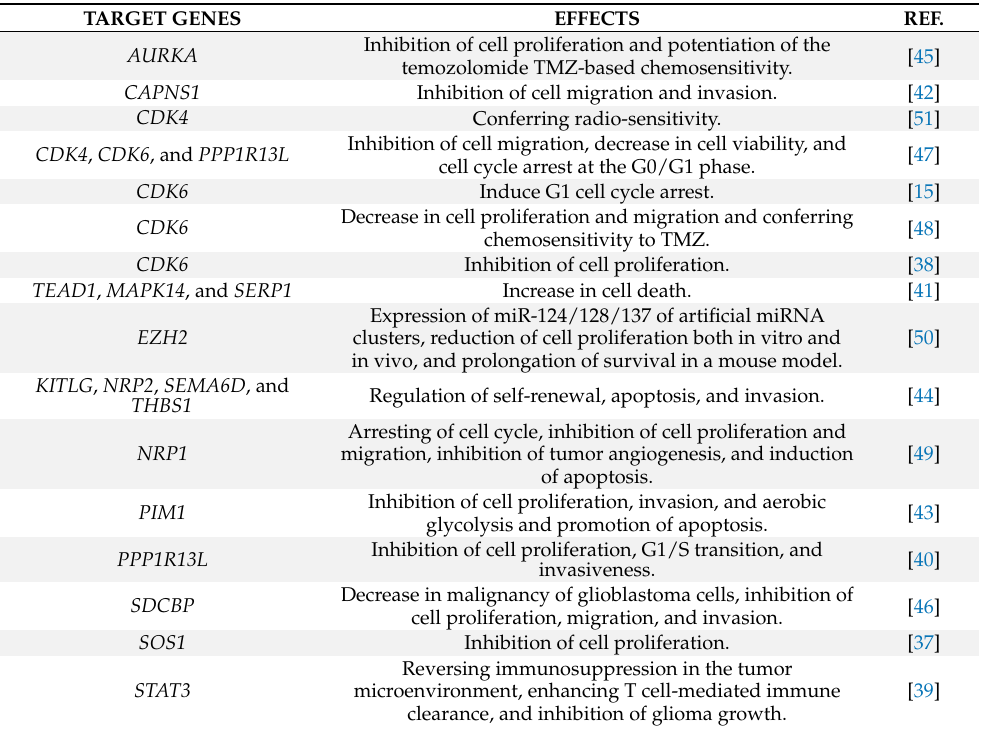
Figure 1. Schematic diagram of the mechanism of microRNA-124 functional repression in cancer cells. In human cancer cells, miRNA expression is generally downregulated, triggering the progression of cancer pathology. miR-124 transcription is repressed by methylation of CpG islands in the genomic region encoding pri-miR-124. In addition, miR-124 is adsorbed and removed by circular RNAs and long non-coding RNAs that have sequences complementary to miR-124. Abbreviations: pri-miR-124, primary microRNA-124; circRNA, circular RNA; lncRNA, long non-coding RNA; EMT, epithelial-mesenchymal transition; AGO, Argonaute.